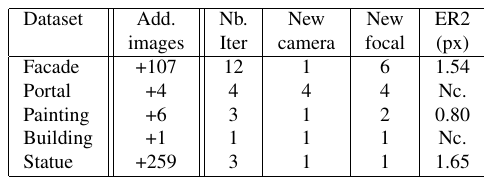
Table 2: Details of multimodal dataset enrichment and results of incremental